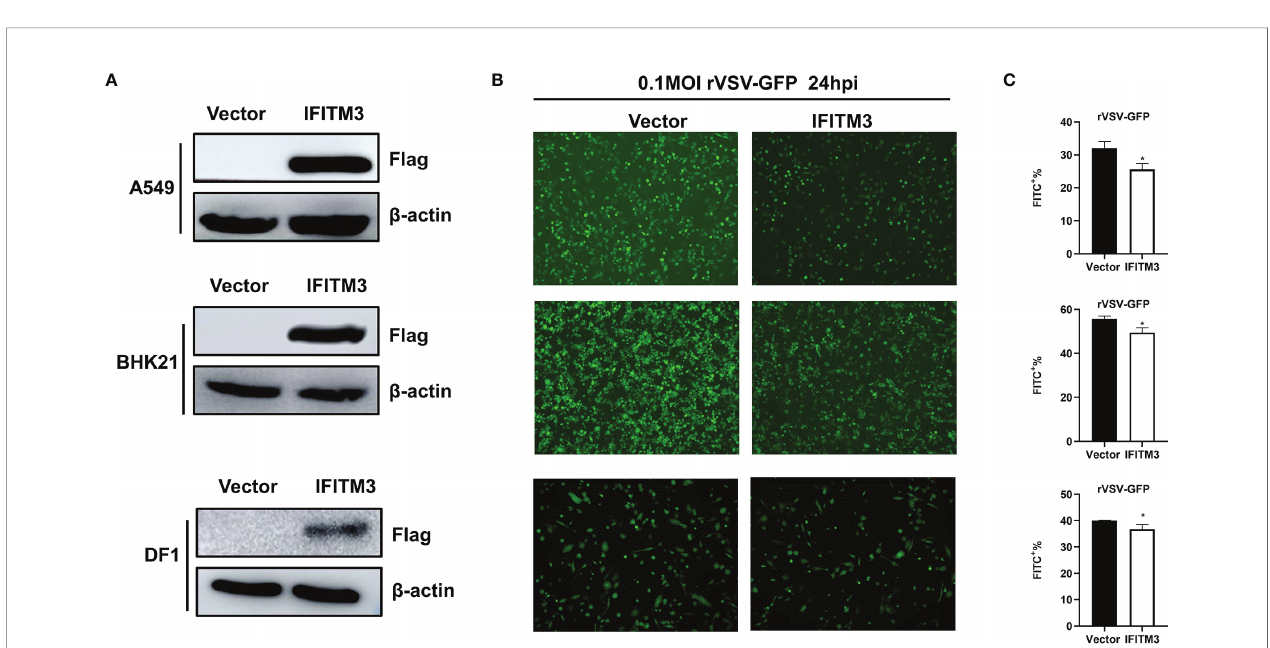
FIGURE 9 | sIFITM3 antagonizes rVSV-GFP proliferation in different cells. A549, BHK21, and DF-1 cells were transfected with pCAGGS-sIFITM3-Flag using Lipofectamine 3000 reagent. 24 h post-transfection, the expression of IFITM3 was examined by Western blot (A) with anti-FLAG antibody. Then the cells were infected with rVSV-GFP at 0.1 MOI and the replication of rVSV-GFP was analyzed by examining via fl uorescence microscopy (B) and fl ow cytometry (C) at 24 hpi. *, p-value